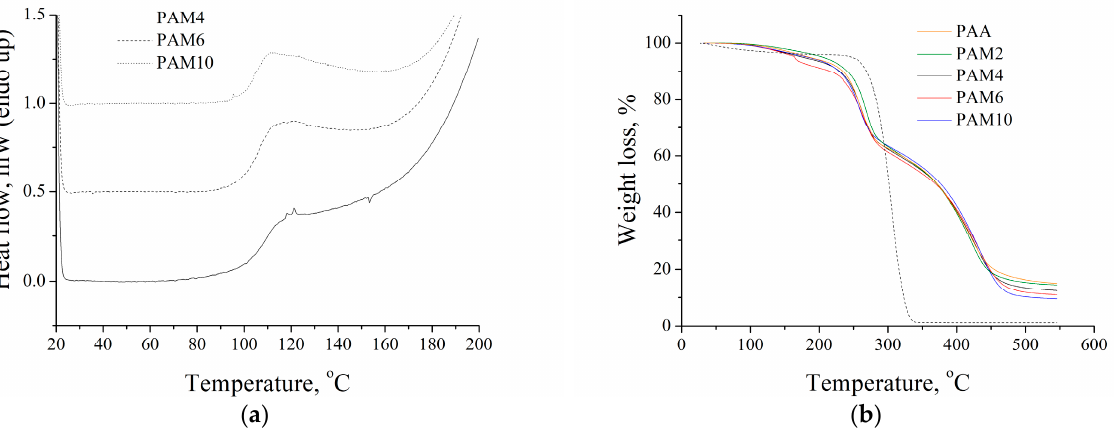
Figure 4. ( a ) DSC curves for polymers PAM2, 6, and 10; ( b ) TG curves for polymers PAA and PAM2-10, together with TG trace for BIBr (dashed line).